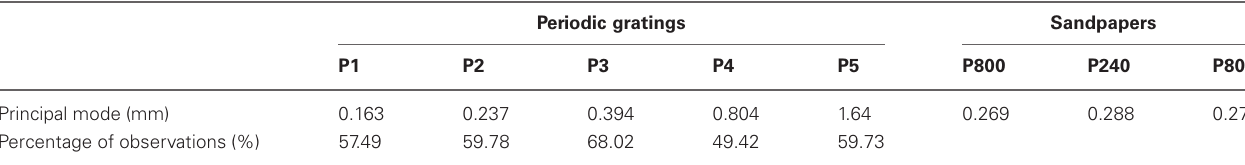
Table 4 | Principal modes for the estimate of spatial period ˆ λ for periodic and non-periodic stimuli.